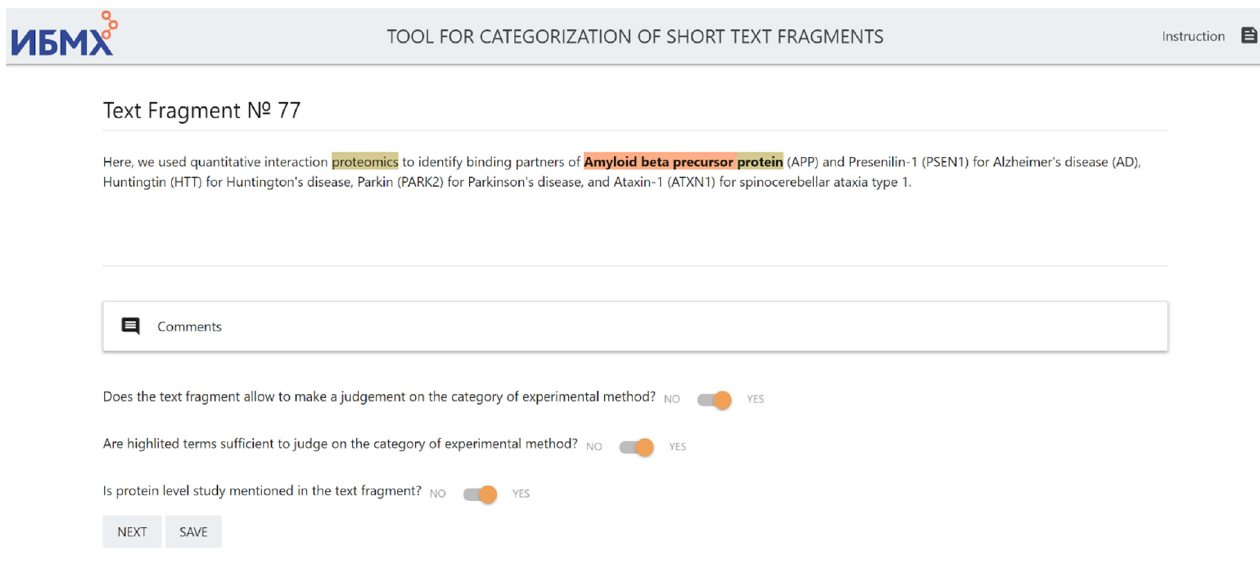
Figure 2. Manual review of text fragments using TCSTF. Names of the biological entities and terms from the dictionary are highlighted in color.